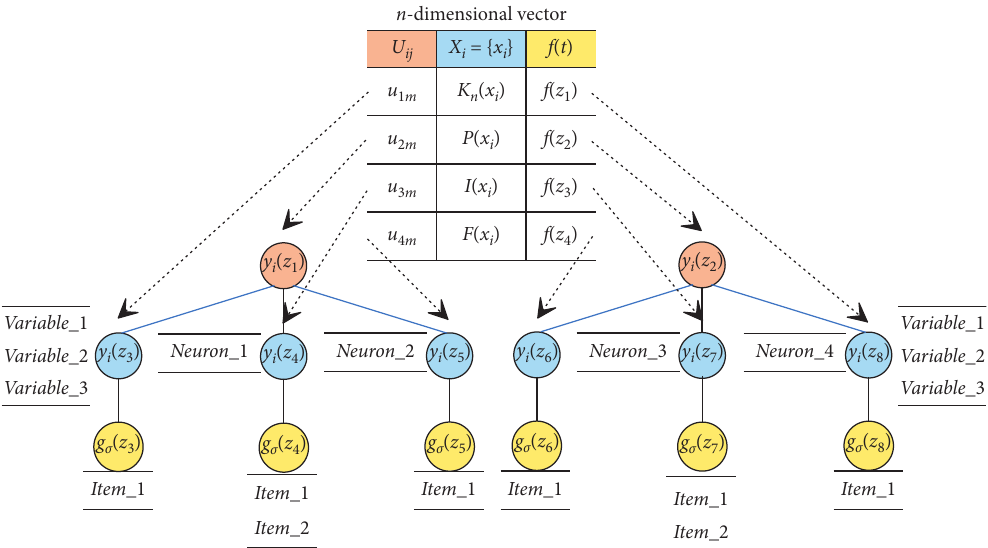
Figure 3: Principles of intelligent hybrid algorithm in analysis of regional economic development differences.